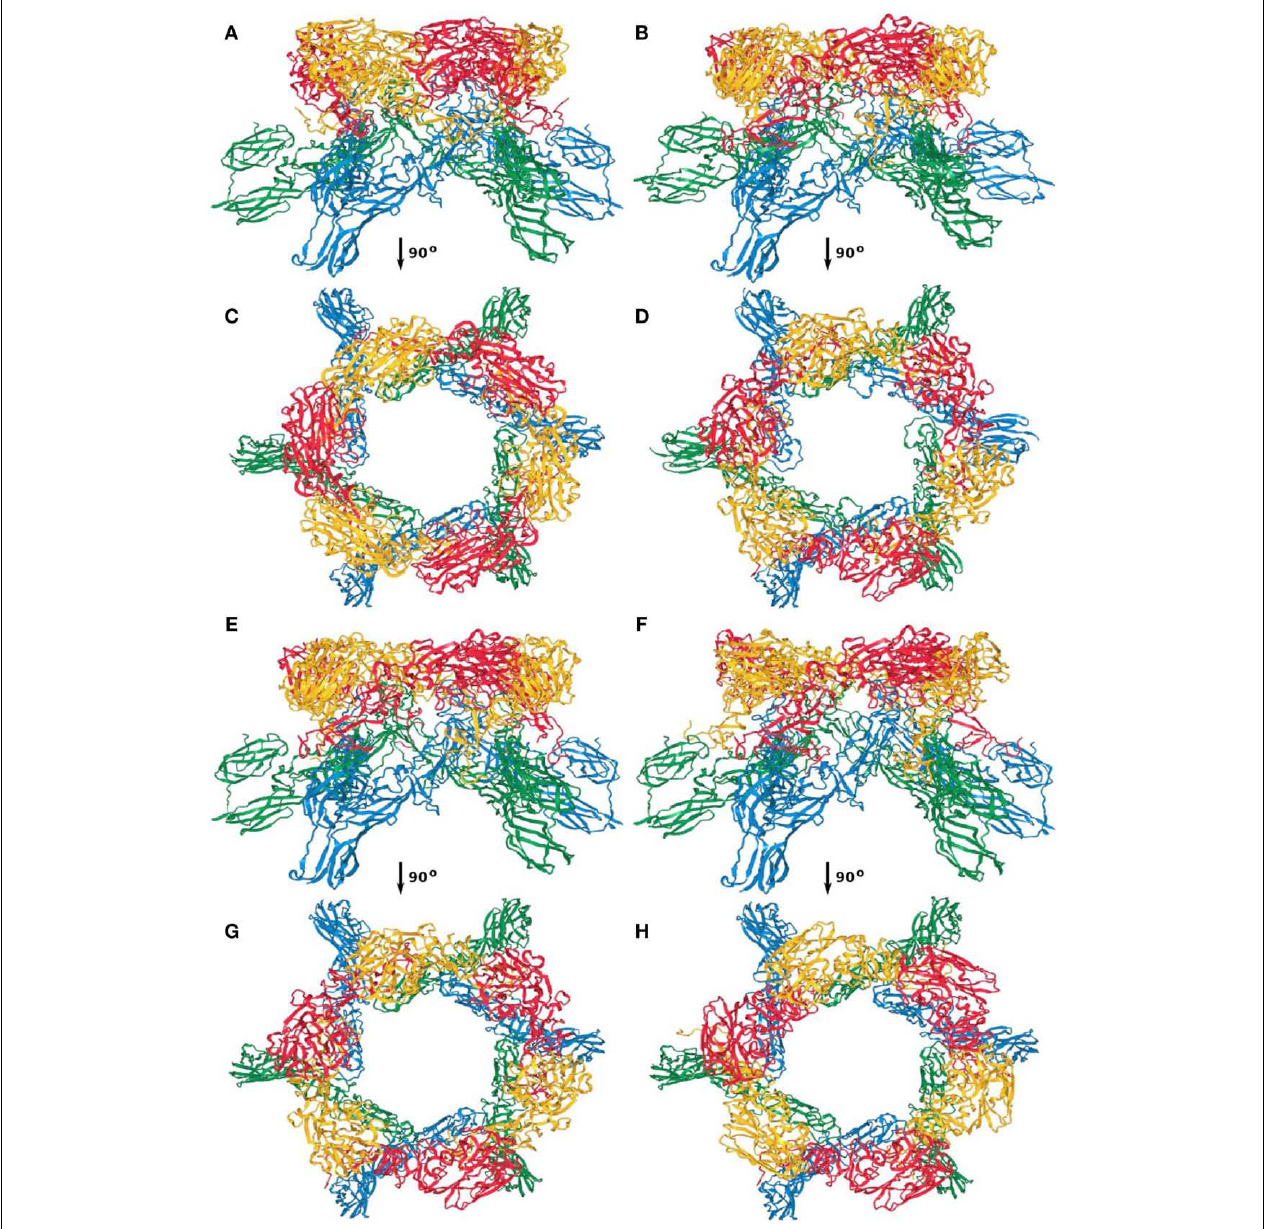
FIGUREA3 | Capsomer quasi-threefold axis; (A,C) first; (B,D) second; (E,G) third; (F,H) fourth top-scoring